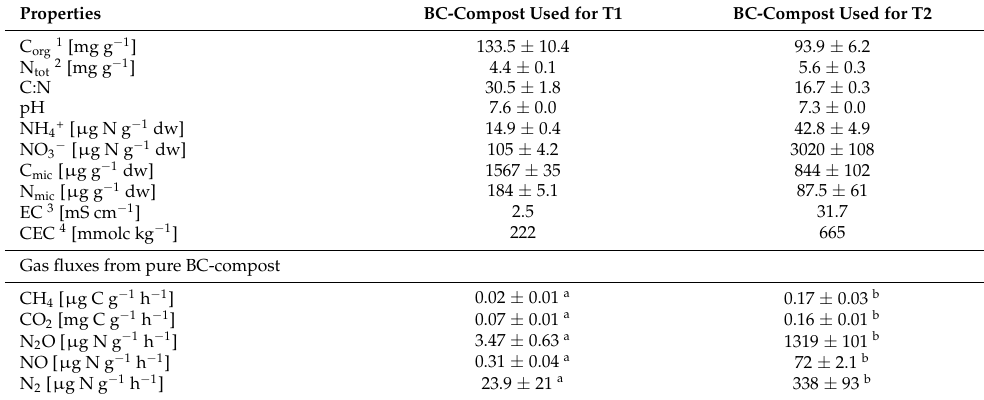
Table 2. Properties and gas fluxes from the two pure BC-compost mixtures before application to the field in 2014. BC-compost used for T2 was enriched with ammonium